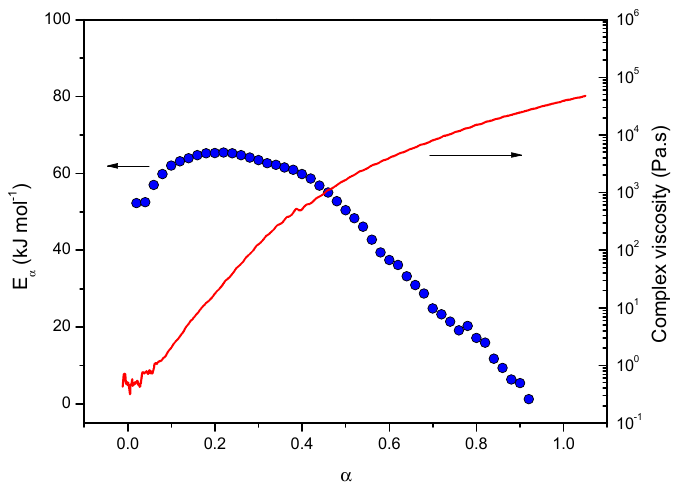
Figure 1. Variation of the effective activation energy ( E α ) with the extent of conversion ( α ) obtained under isothermal conditions (blue circle) and the evolution of the complex viscosity (solid red line).